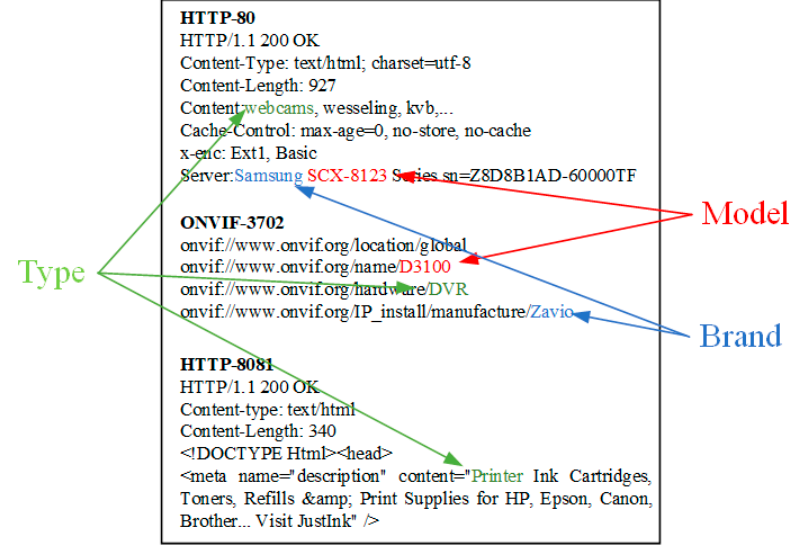
Figure 1. Partial protocol banner information.